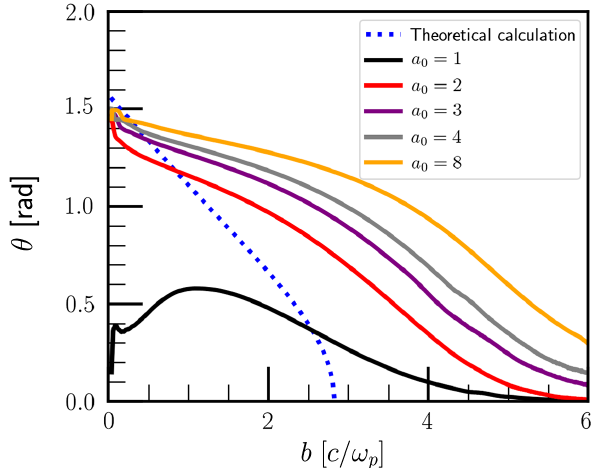
FIG. 2. The scattering angle θ of positrons by the first bubble as a function of different impact parameter b (the positrons starting distance to laser axis) under different peak laser intensities. Theoretical calculation (blue dotted line) is estimated based on Eq. (1) with a 0 ¼ 2 , and solid lines are results from PIC